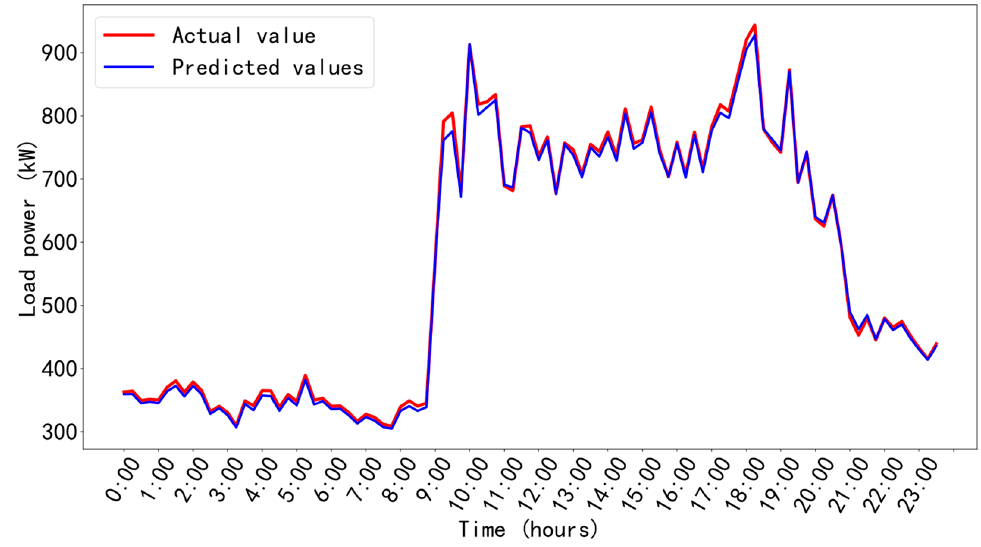
Figure 5. Typical daily load forecasting results.